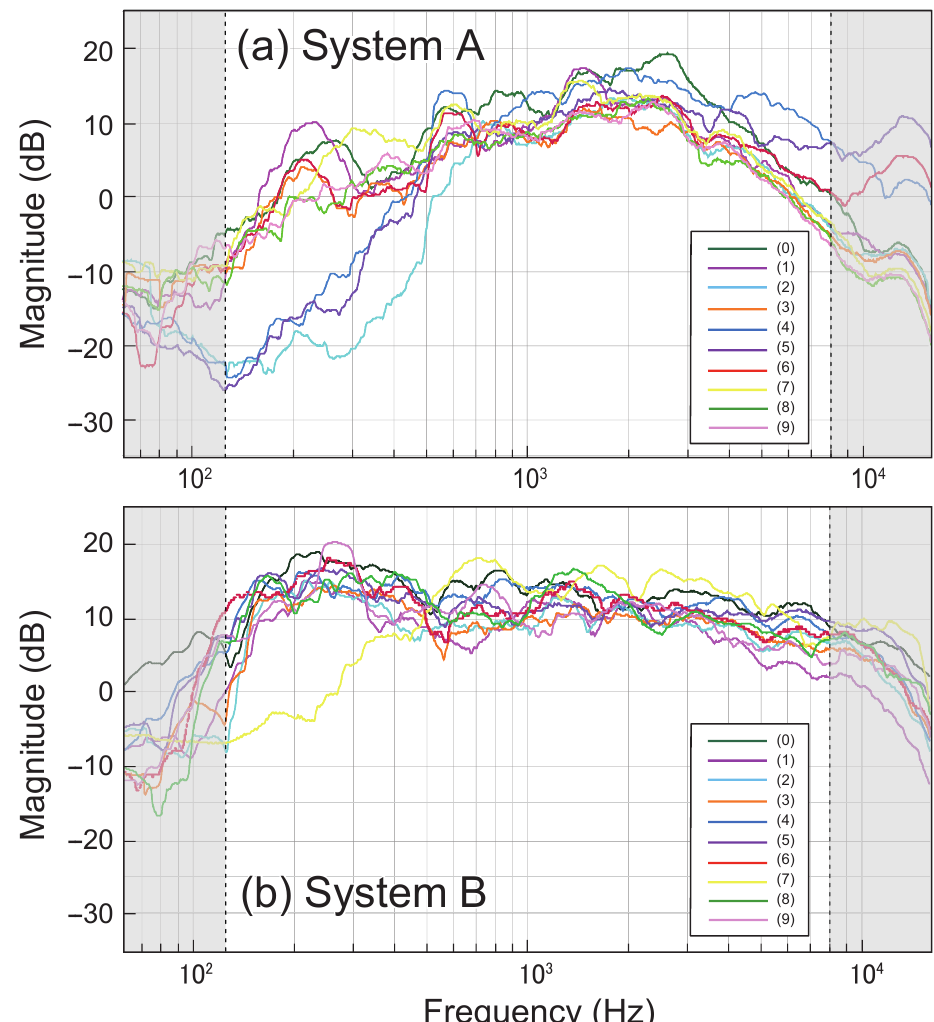
Figure 4. Transfer functions realised by two systems (( a ) System A, ( b ) System B), both measured by using ESS method (Section 2.4) in the unoccupied furnished English room on a day in December 2019. x-axis: frequency (62.5 Hz to 16 kHz, but unshaded for 125 Hz to 8 kHz), y-axis: magnitude ( − 35 dB to 25 dB), depicted with 1/3 octave windowing function in Systune pro (AFMG, Berlin,